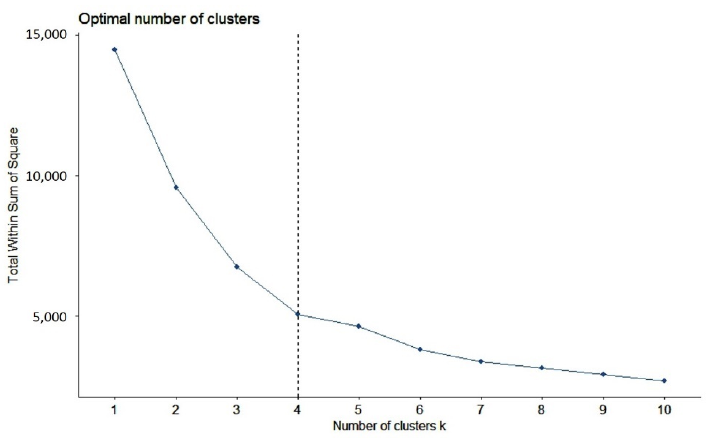
Figure 6. Estimated value of k ‐ means for structure analysis and identification of optimal numbers of clusters.